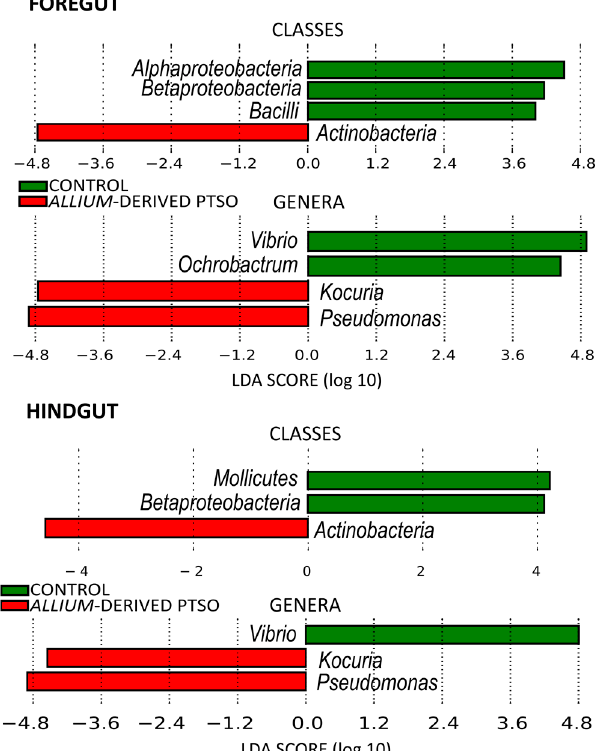
Figure 4. LDA Effect Size (LEfSe) analyses showing bacterial classes and genera that differ signifi- cantly between control fish and those supplemented with Allium- derived PTSO, in the foregut and in the hindgut of European seabass juveniles. Significant LDA Score > 4.0.